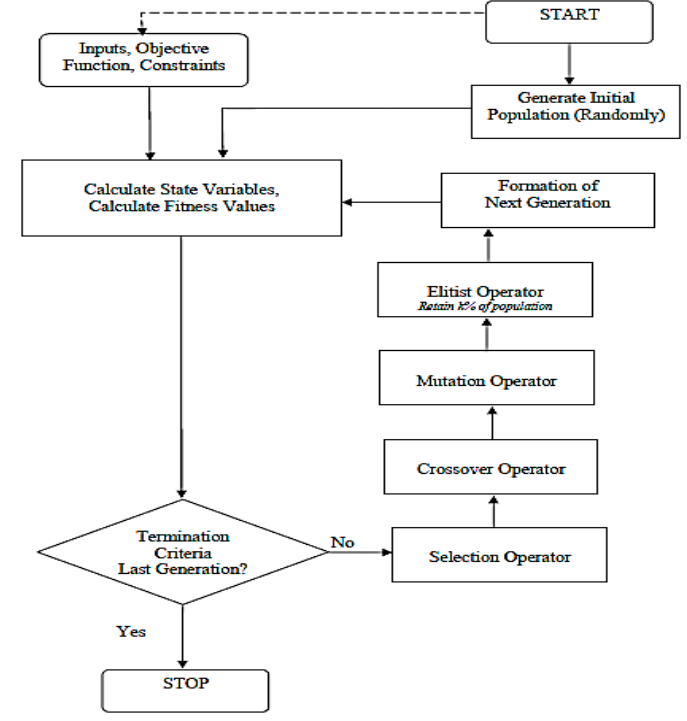
Figure 4. Genetic algorithm (GA) process.